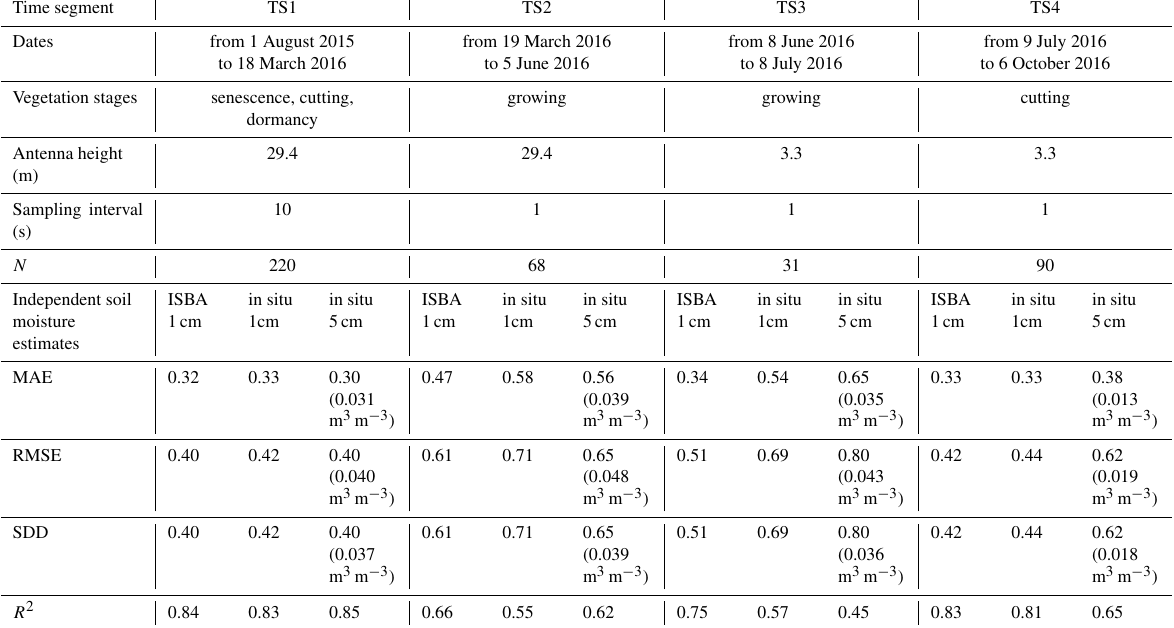
Table 2. Soil moisture scores for four time segments from the comparison between scaled VSM validation data (in situ VSM observations at 1 and 5cm and ISBA VSM simulations at 1cm) and scaled GNSS VSM retrievals (both L2C and L5). Scores in m 3 m − 3 are given (between brackets) for in situ observations at − 5cm. MAE is the mean absolute error, RMSE is the root mean square error and SDD is the standard deviation of difference. N is the number of